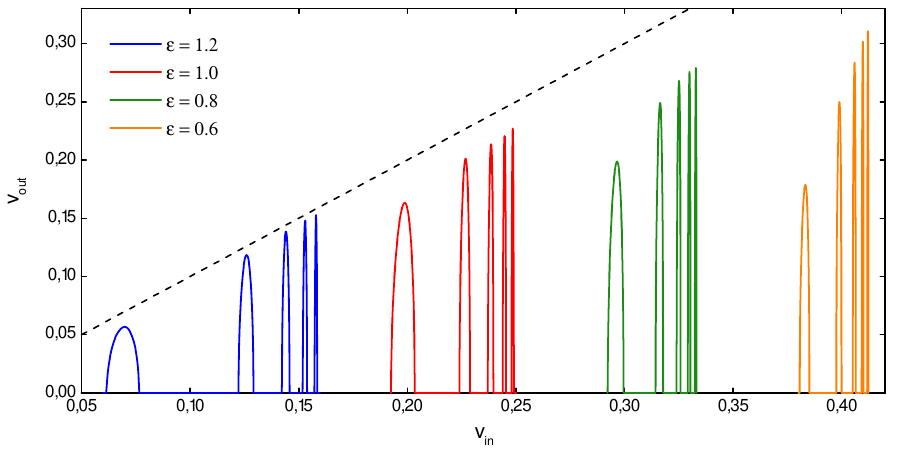
Figure 11 . Two-bounce windows in regime 1: the final velocity of the kink-antikink pair as a function of the initial velocity for various values of the deformation parameter.